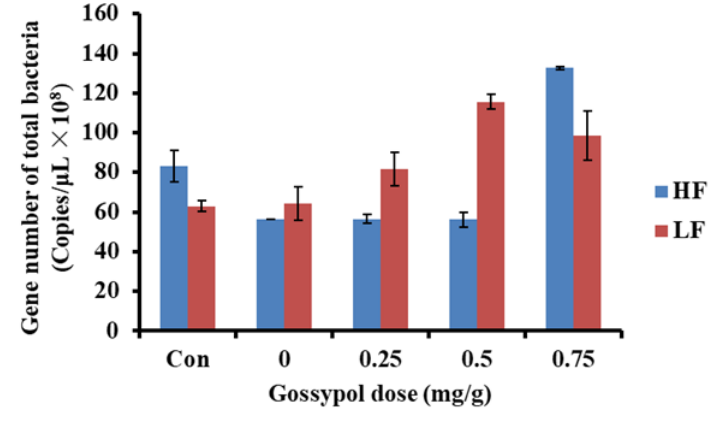
Figure 2. Interaction effect of gossypol dose and ration on the population of total bacteria (HF, Chinese wildrye hay/corn meal—3:2; LF, Chinese wildrye hay/corn